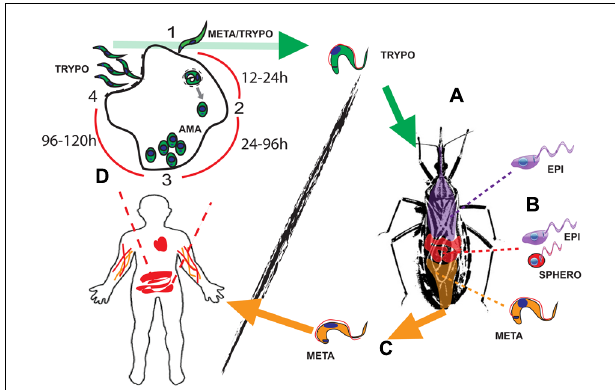
FIGURE 1 | The life cycle of Trypanosoma cruzi . (A) Bloodstream trypomastigotes (green) are ingested with the bloodmeal by the reduviid vector. (B) Those forms will transform into epimastigotes (purple) and intermediate spheromastigotes forms (red) in the insect midgut. (C) New developmental differentiation into metacyclic trypomastigotes (MTs) (orange) will occur in the insect rectum before those forms are released with the feces, infecting the mammalian host. (D) The MTs (1st round of intracellular replication) or bloodstream trypomastigotes (green) parasites will then invade a wide range of nucleated cells in an intracellular cycle composed of up to four steps: (1) Attachment, invasion, and parasitophorous vacuole formation (0–4 h). (2) Differentiation into intracellular amastigote forms and release from parasitophorous vacuole (12–24 h). (3) Amastigote replication by binary fission (24–72 h). (4) Differentiation into bloodstream trypomastigotes and release from the infected host cell (72–120 h). The bloodstream forms are then ready to either invade new cells or been taken by the insect vector. Parasite life cycle stage abbreviations: AMA, amastigotes; META, metacyclic trypomastigotes; TRYPO, bloodstream trypomastigote; EPI, epimastigotes; SPHERO,